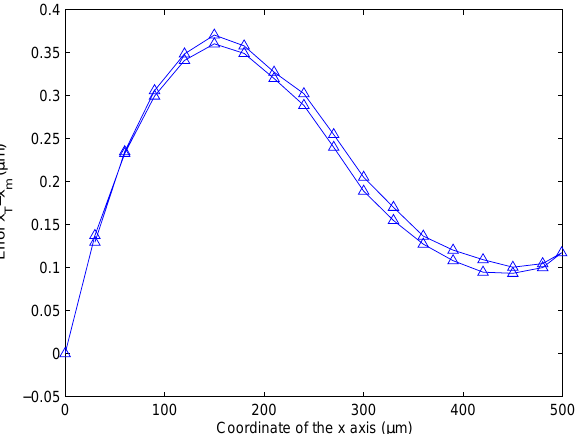
Figure 2. Geometric errors of the nanopositioning stage where x T is the target, x m is the measured position along x . The lower curve corresponds to forward motion while the bottom one to the